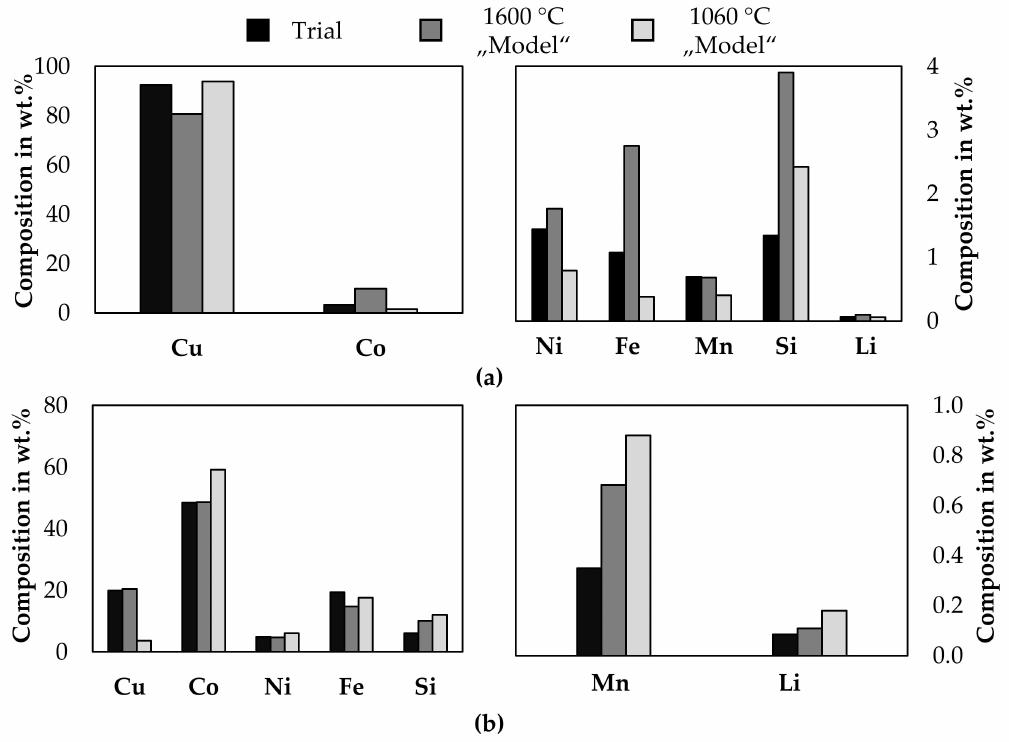
Figure 11. Comparison between analyzed metal composition and thermochemical model. ( a ): copper-rich phase; ( b ): cobalt-rich